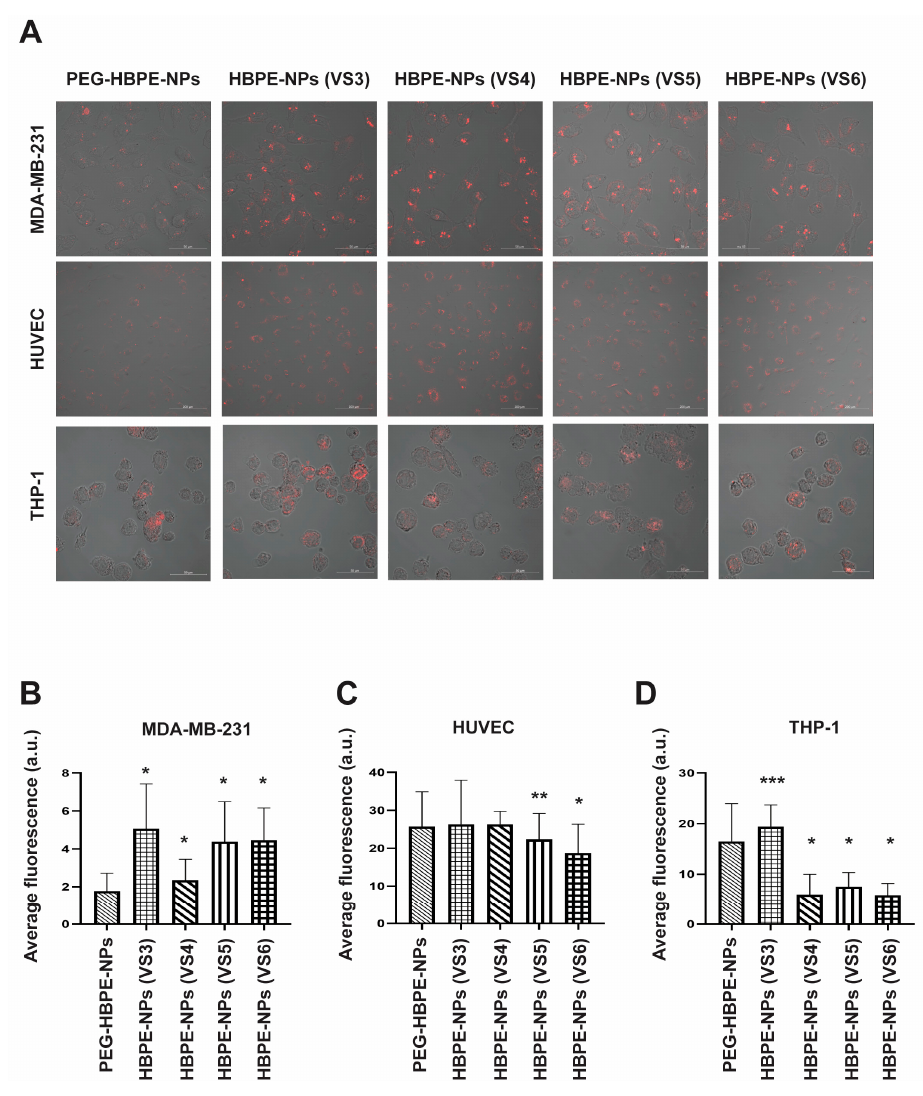
Figure 2. Increased cancer cell uptake and decreased monocyte uptake were observed with HBPE- NPs pre-treated with sera collected from mice at the later stages of the IAV infection. ( A ) HBPE-NPs (NPs) pre-coated with VS3-6 were compared to PEG-HBPE-NPs. Representative confocal microscopic images (upper plane) are shown of MDA-MB-231 cells (upper row), HUVEC cells (middle row), and THP-1 cells (bottom row). In columns are cells treated with DiI dye-encapsulated PEG-HBPE-NPs (first column), HBPE-NPs (VS3) (second column), HBPE-NPs (VS4) (third column), HBPE-NPs (VS5) (fourth column), and HBPE-NPs (VS6) (fifth column). Red fluorescence (DiI dye) is indicative of nanoparticle uptake in cells. The scale bar represents 50, 200, and 50 µm for MDA-MB-231 cells, HUVEC cells, and THP-1 cells, respectively. Images were acquired with a Zeiss LSM 710 microscope at 20× (MDA-MB-231 and THP-1 cells) and 10× (HUVECs) magnifications. ( B – D ) Red fluorescence (DiI dye) quantification bar graphs of ( B ) MDA-MB-231, ( C ) HUVEC, and ( D ) THP-1 cells treated with PEG-HBPE-NPs, HBPE-NPs (VS3), HBPE-NPs (VS4), HBPE-NPs (VS5) or HBPE-NPs (VS6) after 24 h. Bar graphs represent the average DiI fluorescence per cell. Quantification data originate from images taken by a Cytation 5 Cell Imaging Multi-Mode Reader (representative images in Figure S2) to capture total nanoparticle fluorescence. MDA-MB-231 and HUVEC fluorescence data were acquired from a minimum of 100 cells. THP-1 fluorescence data were acquired from a minimum of 50 cells. Fluorescence was quantified using Zen Blue software. Data represent mean ± standard deviation. * p -value <0.001, ** p -value = 0.0034 and *** p -value = 0.0199 relative to PEG-HBPE-NPs. Representative data from three experimental replicates are shown.